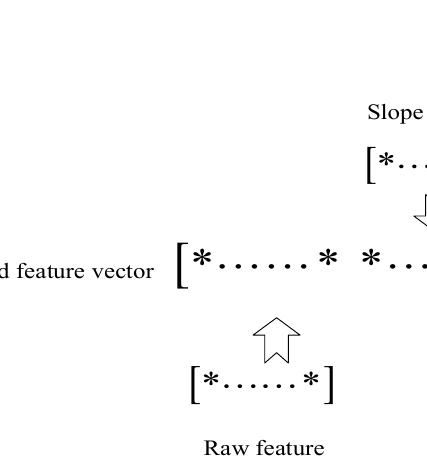
Figure 7. Schematic diagram to obtain a fused feature vector.